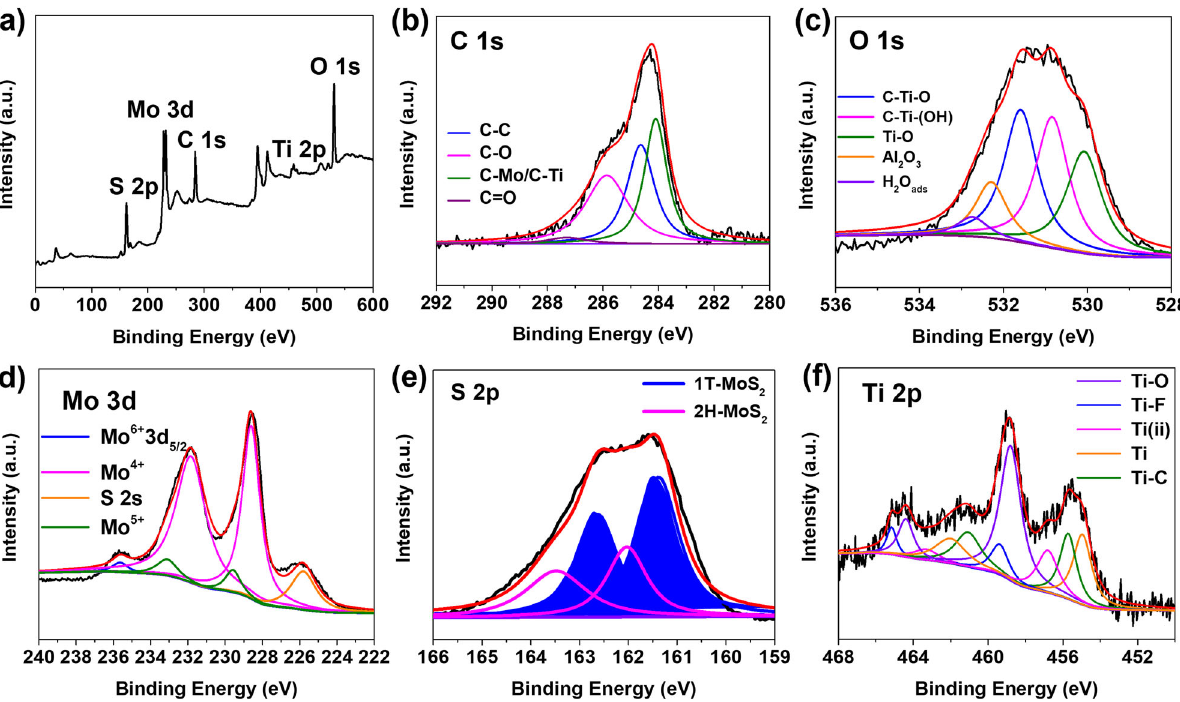
Fig. 4 The XPS characterization of the MTC composite. a The complete XPS survey spectra of MTC100. Deconvoluted XPS spectra showing the binding energy of ( b ) carbon, c Oxygen, d Molybdenum, e Sulfur, f Titanium,